Question: Write the caption for this figure.
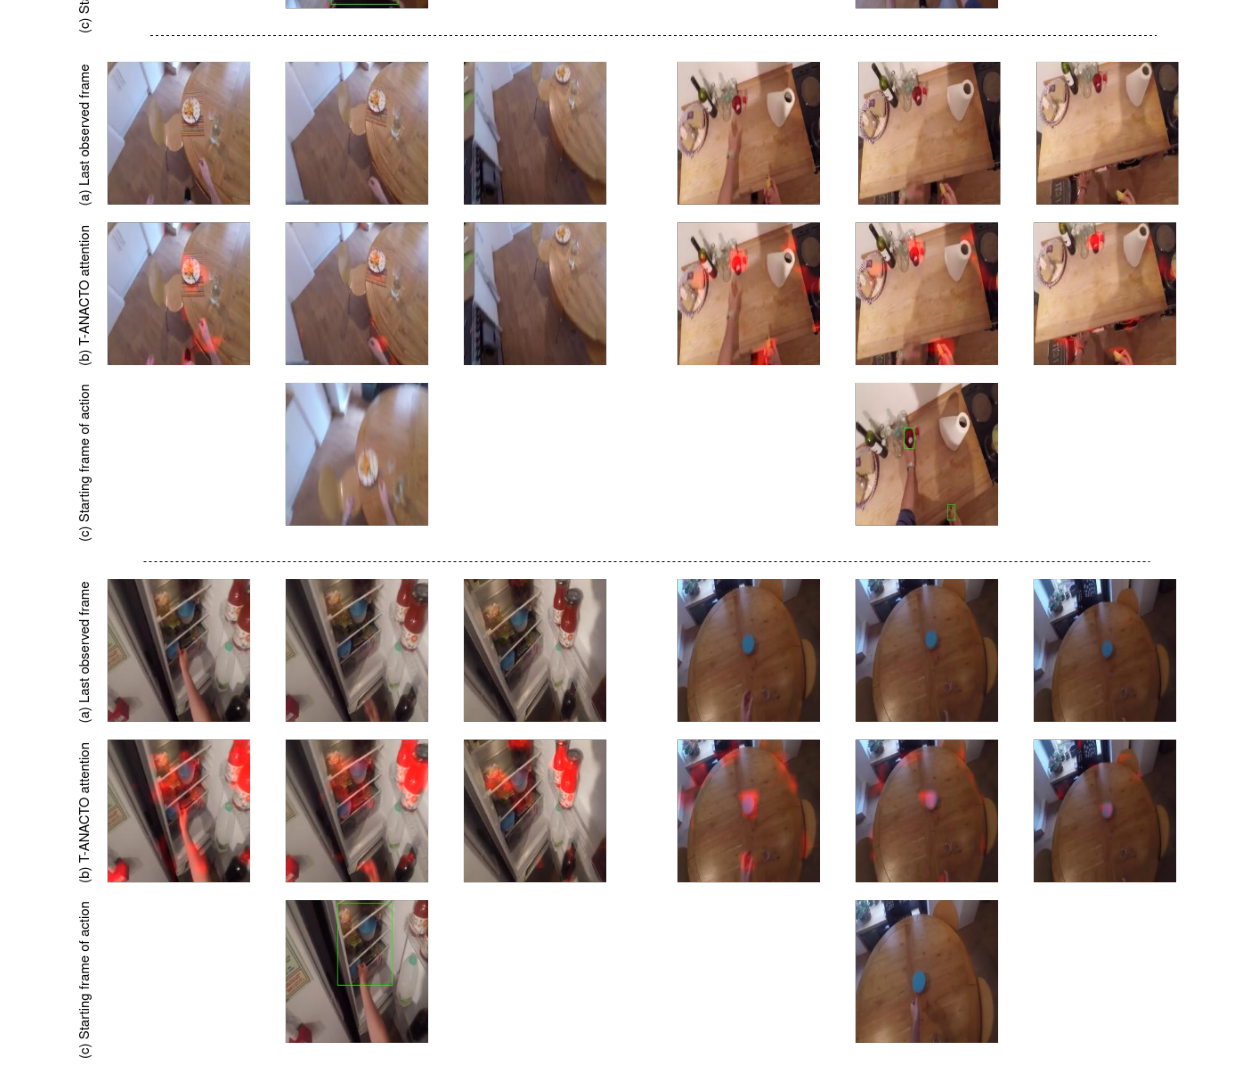
Answer: Results show the diversity of spatial attention for the last observed frame preceding the beginning of an action segment for different setups of TTC window for τa = 0.25, 0.5, 1.0 seconds. The attention corresponds to the red region in the image. The regions tend to appear more assertive as the model examines frame closer to action segments i.e; as the τa is decreased. This also attributes to a higher accuracy of the model for shorter time to contact window.